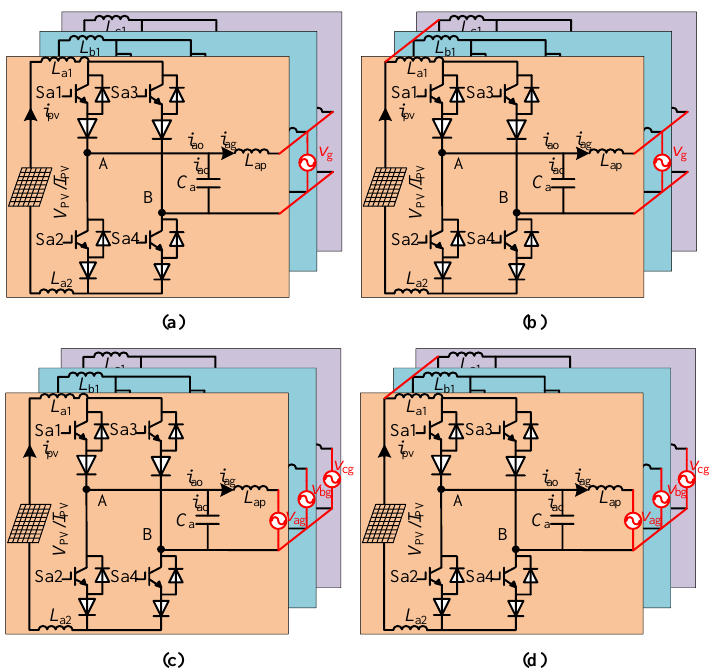
Figure 1. 3CH4 current source grid-connected inverter, A and B are two connection points: ( a ) the AC sides of three independent CH4 are connected in parallel to a single-phase grid; ( b ) the AC sides of the common dc bus type CH4 are connected in parallel to a single-phase grid; ( c ) the AC sides of three independent CH4 are connected to a three-phase grid, respectively; ( d ) the AC sides of the common dc bus type CH4 are connected in parallel to a three-phase grid, respectively.